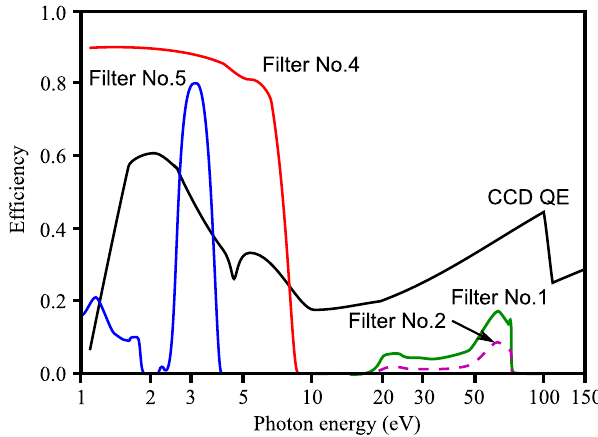
FIG. 3. CCD quantum efficiency (QE) and transmission effi- ciencies for the filters from Table I as a function of the photon energy. QE, black curve; filter No. 1, green curve; No. 2, purple curve; No. 4, red curve; No. 5, blue curve. The transmission efficiency of filter No. 3 was omitted for clarity.